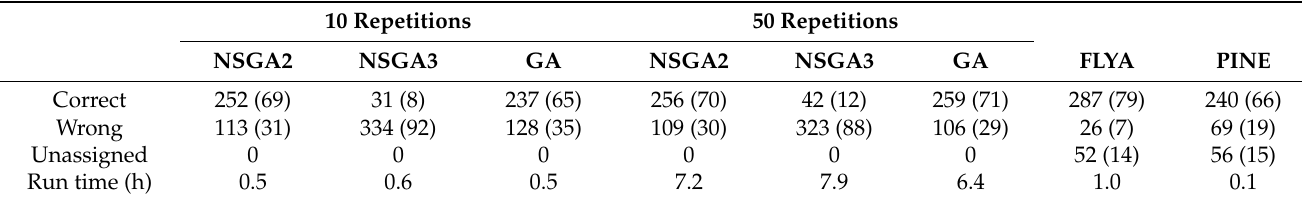
Table 3. Assignment results for the 4th fragment of Fes SH2 for different repetition parameter values. 1.